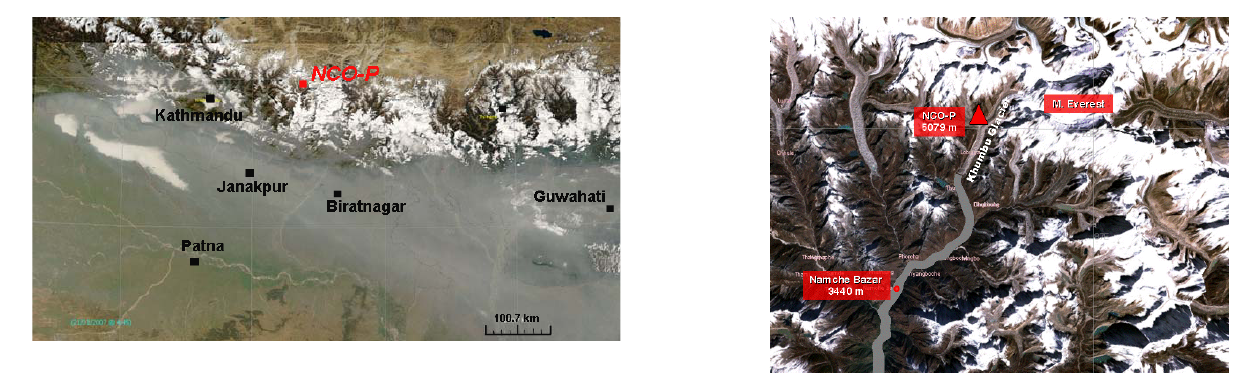
Fig. 1a. The Atmospheric Brown Cloud on the southern slope of Hi- malayas (MODIS sensor on NASA Terra satellite, 21 January 2007) and location of NCO-P (Nepal Climate Observatory-Pyramid, red point). The main cities in the area are also reported.